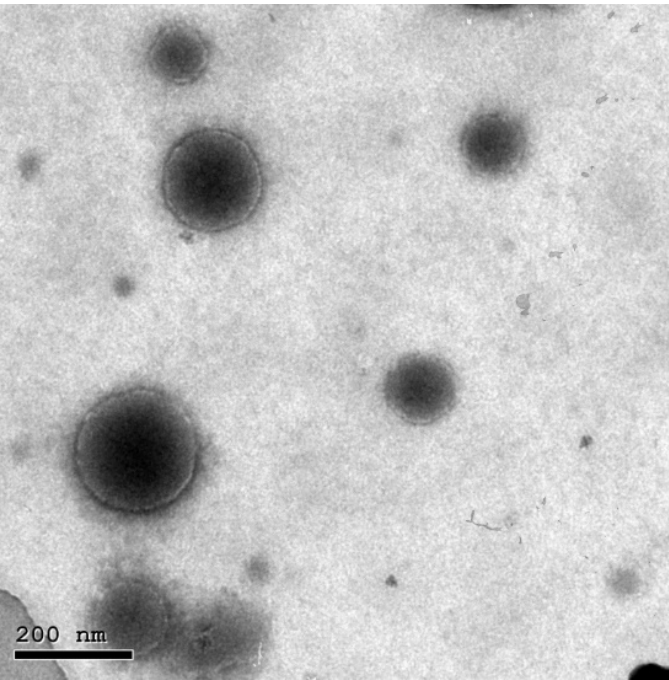
Figure 3. TEM micrograph of representative resveratrol-loaded bilosomes (B9) showing scattered perfect spherical particles with no aggregations.